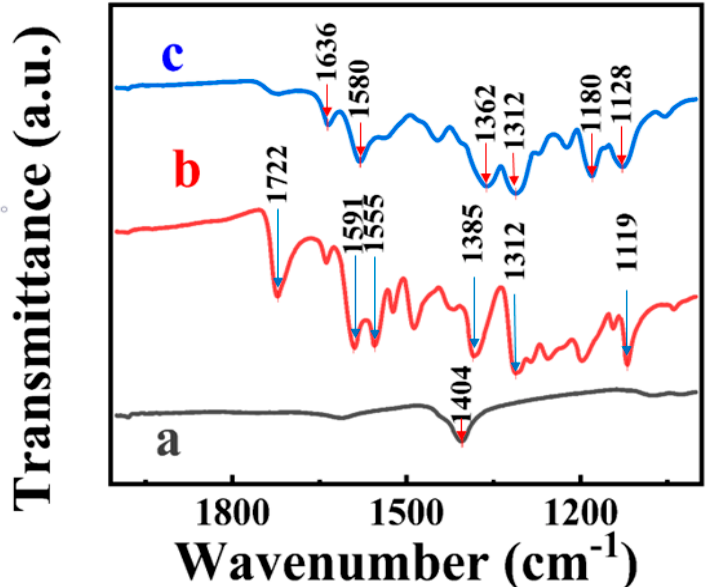
Figure 5. FTIR spectra of (a) as-received Fe 2 O 3 , (b) gallocyanine, (c) Fe 2 O 3 , containing adsorbed gal- locyanine.